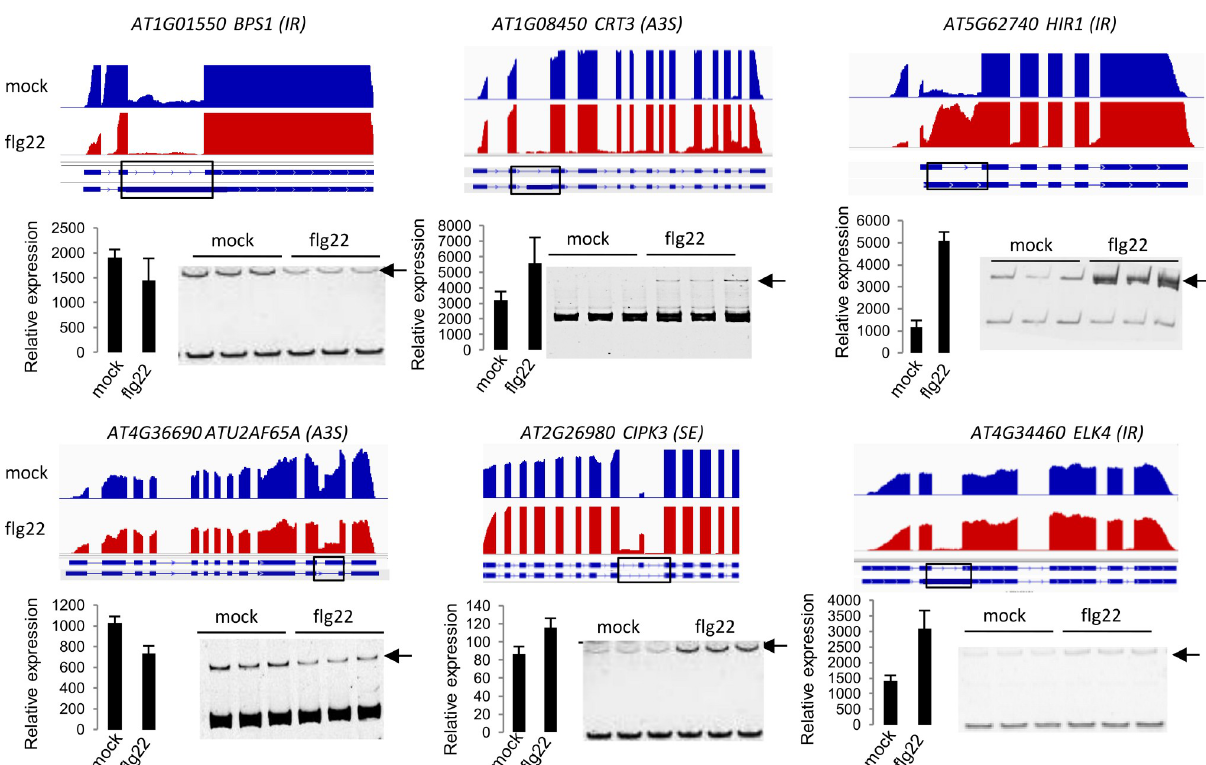
Fig 2. RT-PCR analysis of selected differential splicing events in response to flg22. Normalized RNA-seq coverage data are shown in the upper part of each panel. Scale is the same in each track. Relative expression for each gene was calculated based on the normalized RNA-seq read count produced by DEseq2. A black arrow marks the position of the alternative isoform. RT-PCR was performed on 3 biological replicates.